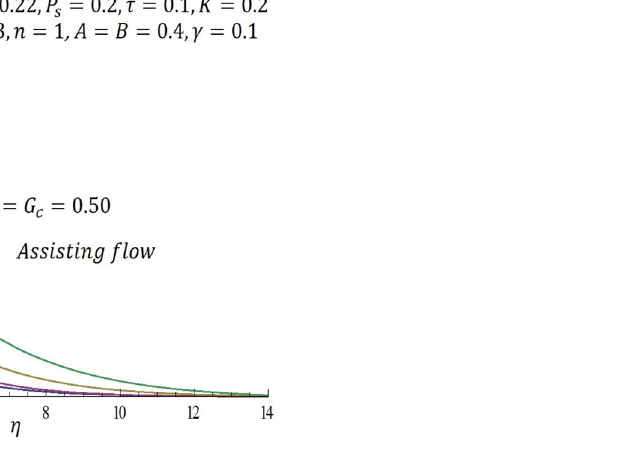
Figure 6. Effect of ξ on velocity profile when G r = G c = 0.5